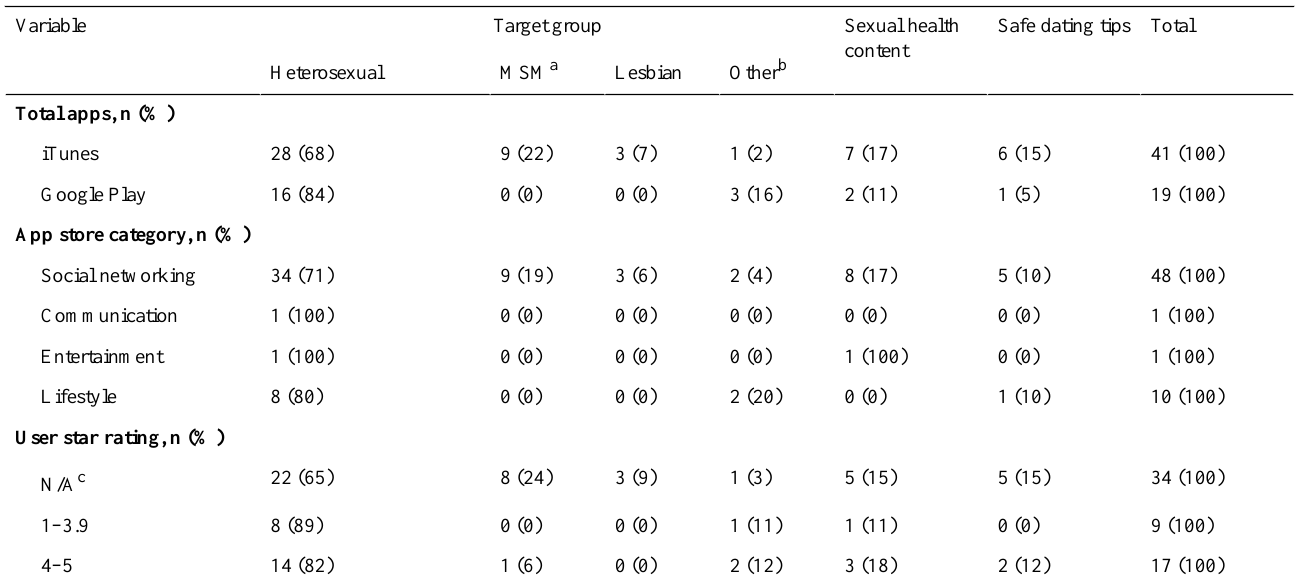
TotalSafe dating tipsSexual health contentTarget